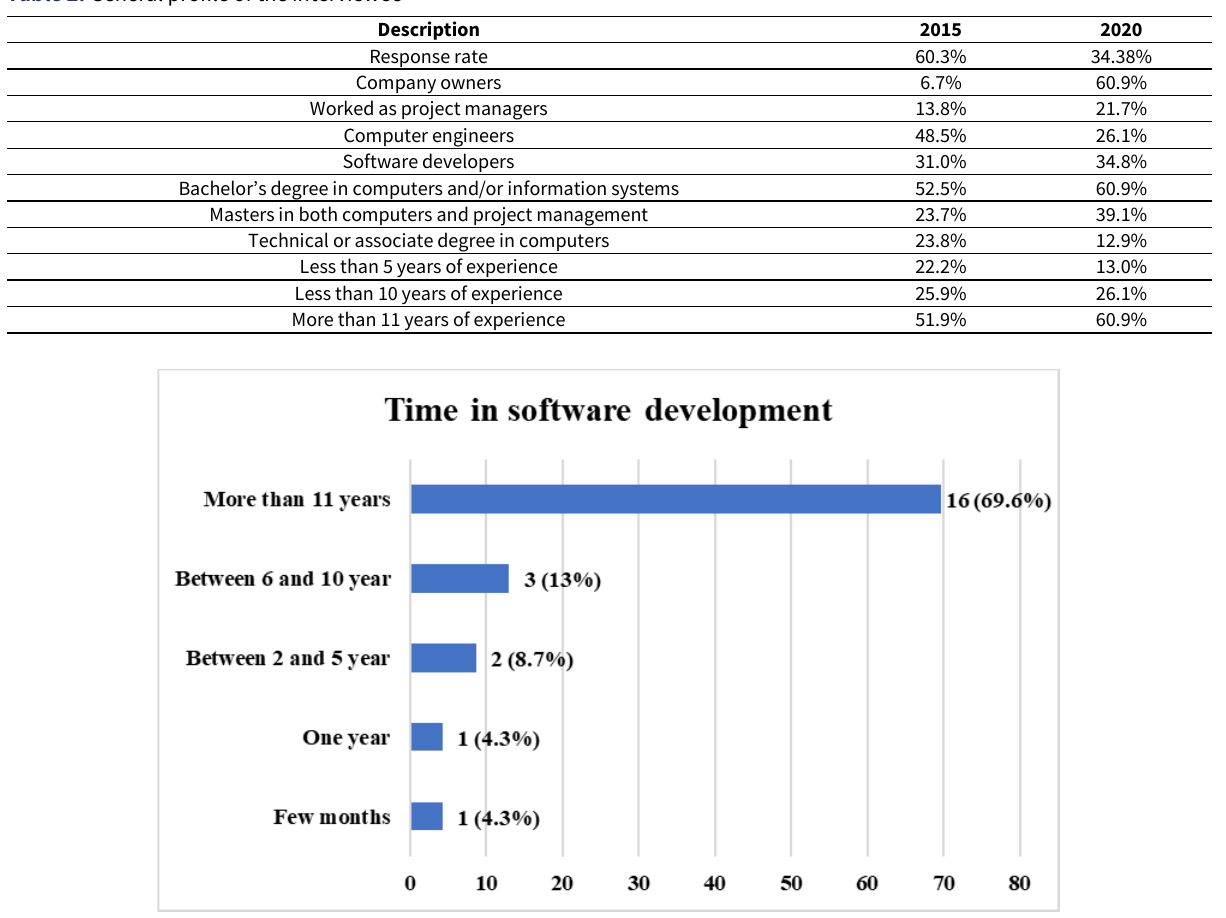
Figure 2. Time spent on software